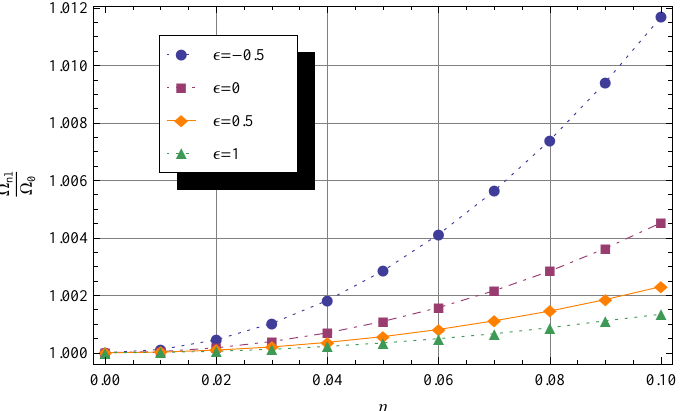
Figure 3. Frequency ratio Ω nl / Ω 0 for different values of η and (cid:101) . The other parameters are q 1 = 2, q 2 = 2, λ = 0, K R = 0, and K T = 0. Table 5. The first three dimensionless frequency Ω nl , for different values of K R and (cid:101) . The